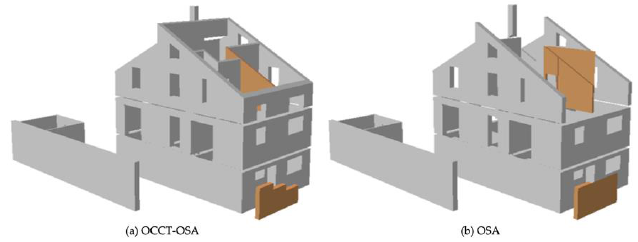
Figure 18. Walls generated by ( a ) OCCT-OSA and ( b ) OSA.